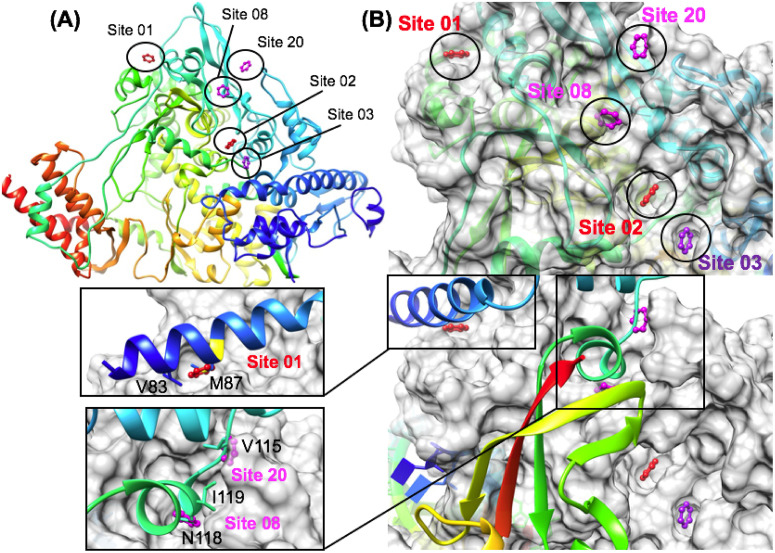
Favorable aromatic pharmacophore binding sites identified on the Nsp12 RdRp.Favorable sites are shown in red or magenta on the rainbow ribbon structure shown in (A) and on the gray binding surface shown in (B). Several protein-protein interaction (PPI) sites on the Nsp12 binding surface were identified as favorable aromatic pharmacophore binding sites shown in (B). Site 01 (red), Site 08 and Site 20 (magenta) represent Nsp12 / Nsp8 heterodimer interaction sites where the Nsp8 ribbon is shown (B) in rainbow binding to the complementary Nsp12 surface shown in gray. Zoom in surface views are shown to illustrate corresponding Nsp8 hydrophobic residues side chains that participate in PPI on the Nsp12 surface.